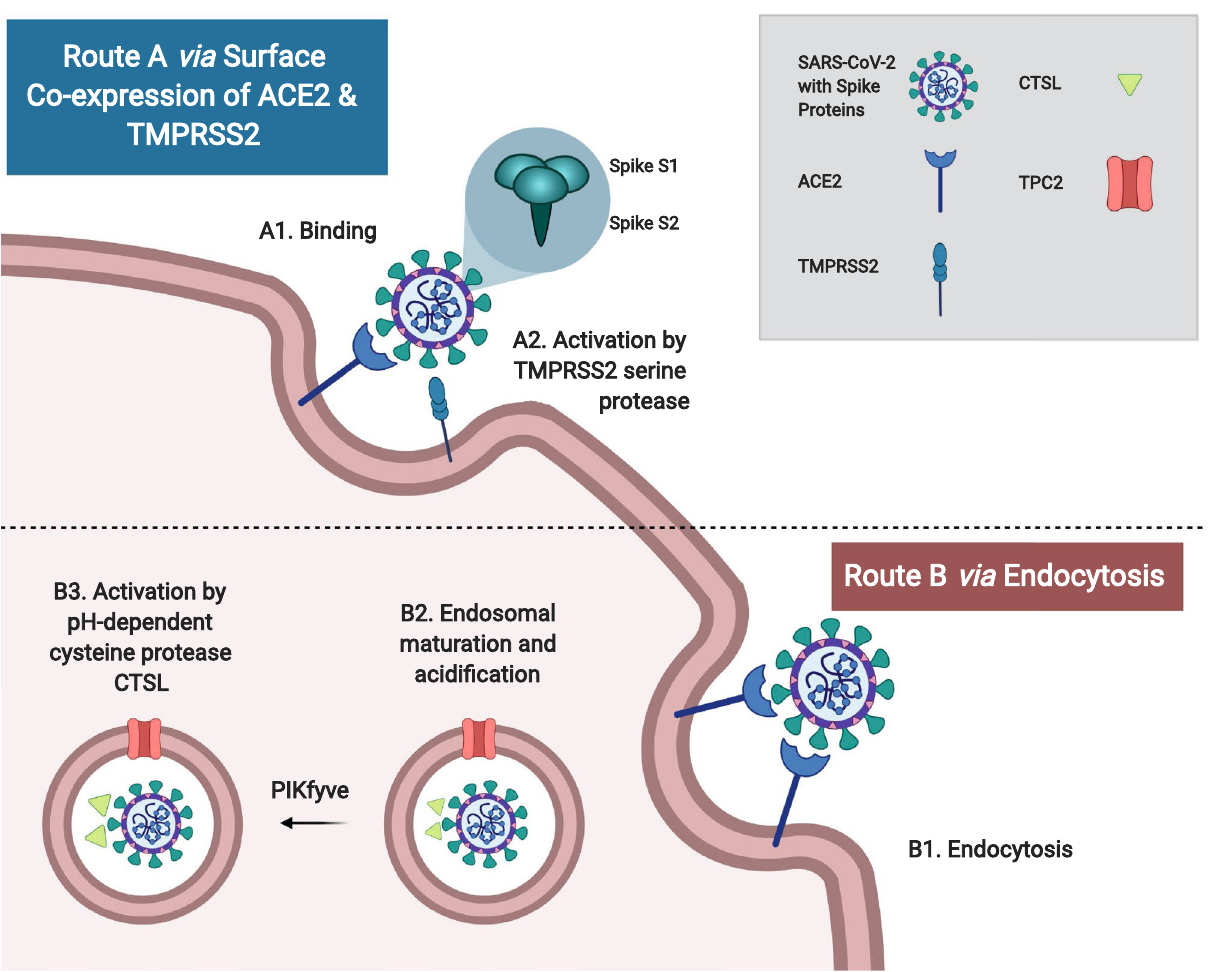
Figure 1. Routes of coronavirus entry. Severe acute respiratory syndrome coronavirus-2 (SARS-CoV-2) contains a transmembrane spike (S) glycoprotein, which is important for (i) host cell receptor binding by the S1 subunit, and (ii) subsequent S2 subunit activation via S protein proteolytic cleavage to mediate virus- cell fusion and entry. There are two major routes of viral activation: Route A: When angiotensin-converting enzyme 2 (ACE2) and transmembrane protease serine 2 (TMPRSS2) are co-expressed on the host cell surface, SARS-CoV-2 will bind to ACE2 and become activated by TMPRSS2 via proteolytic cleavage to mediate viral- cell fusion. Route B: If there is no surface expression of a protease, SARS-CoV-2 can undergo endocytosis, endosomal maturation (mediated by two pore channel subtype 2 (TPC2) and phosphatidylinositol 3-phosphate 5-kinase (PIKfyve)), followed by cleavage with pH-dependent cysteine protease cathepsin L (CTSL). Figure created with